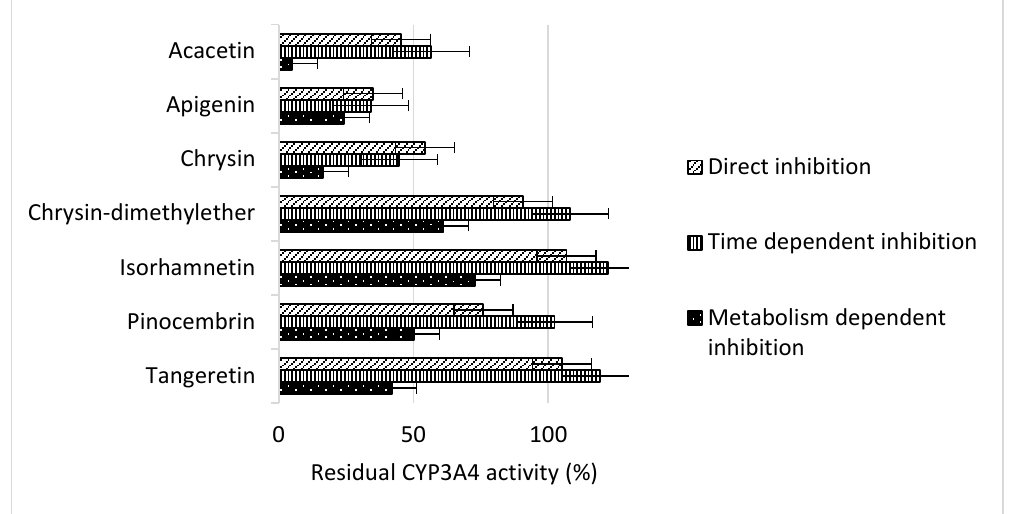
Figure 3. Residual enzyme activity of CYP3A4 determined after incubation with individual flavonoids, and expressed as a percentage of control reaction without addition of flavonoids. Flavonoids were preincubated with enzyme with and without NADPH coenzyme to test metabolic, and time dependent inhibition, respectively. Direct inhibition had no preincubation.